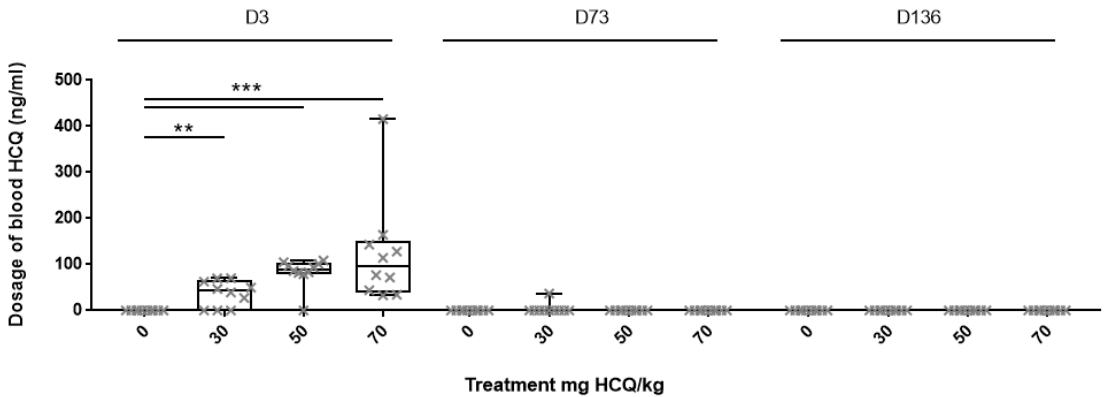
Figure 1. Serum hydroxychloroquine (HCQ) levels in C57BL/6JRj mice treated with intraperitoneal injection of HCQ. Each cross represents one animal’s dosage. Boxplot expressed median and quartile. Dosages were analysed by the Kruskal–Wallis test. Mann–Whitney was used for multiple comparisons. ** p < 0.01; *** p < 0.001.